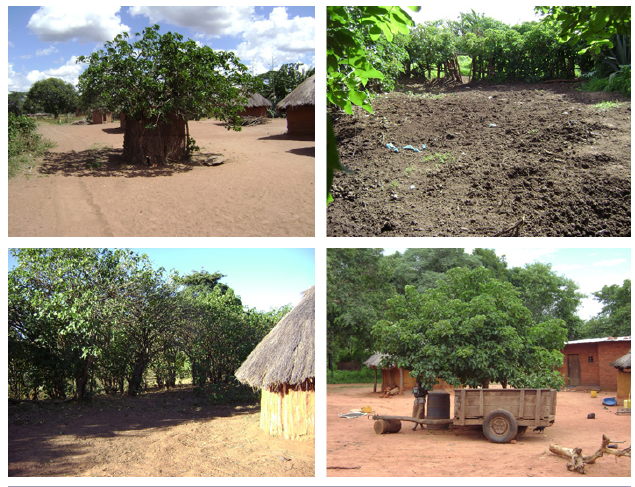
Fig. 3 . Established village uses of jatropha (clockwise from top left): as live posts holding the straw mats (walls) of a bathroom; as part of a cattle kraal (picture taken from the inside); as a single shade tree in the yard (an ox cart parked underneath); and as a hedge around the